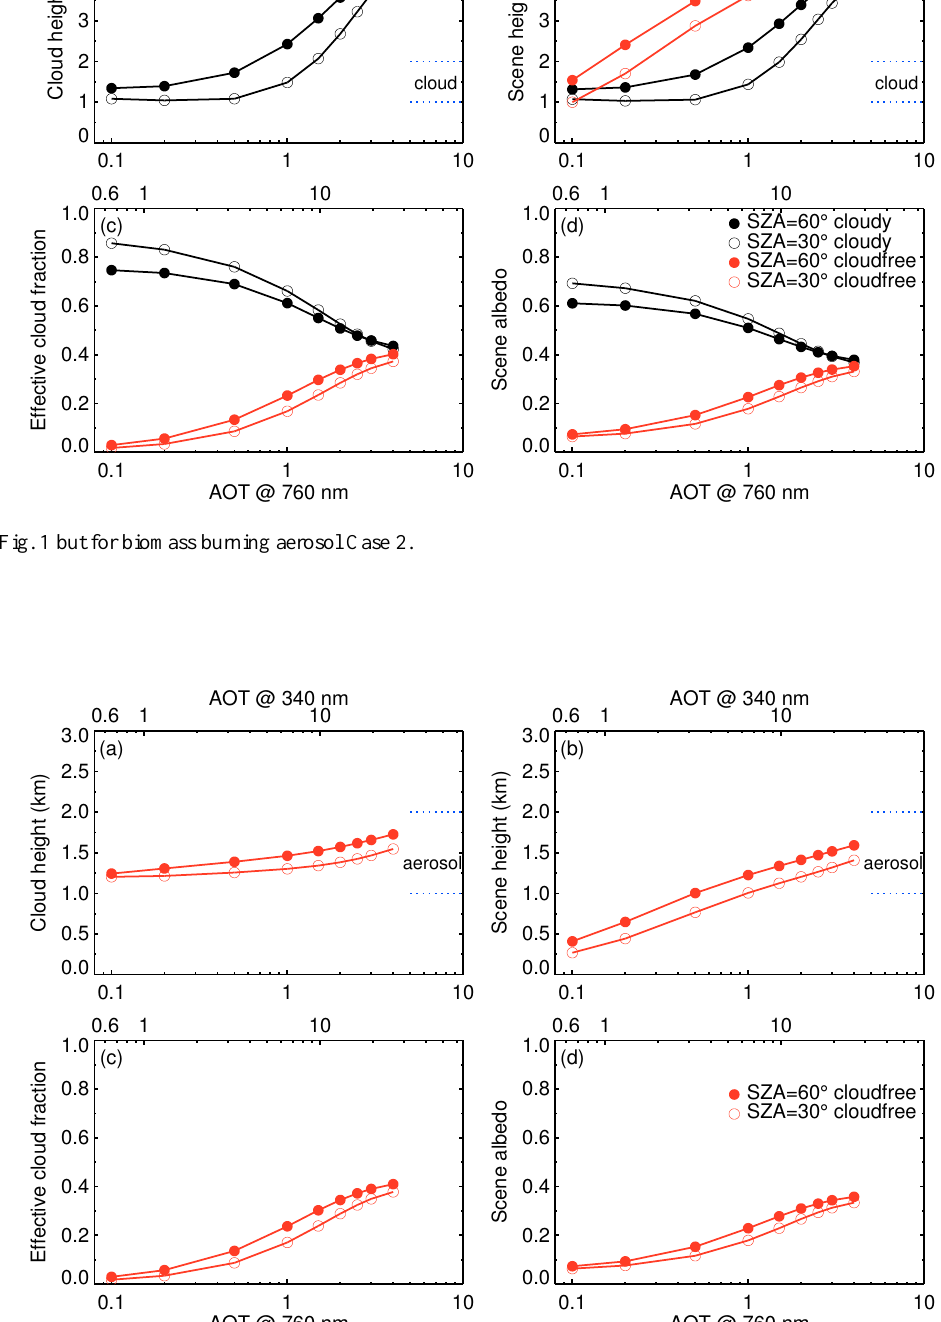
Atmos. Chem. Phys., 12, 9057–9077,